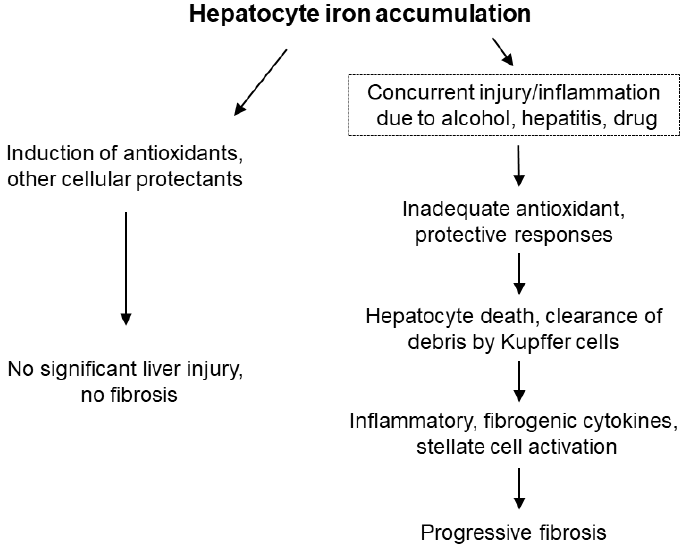
Figure 1. Potential outcomes of hepatocyte iron accumulation. In the setting of iron accumulation alone, iron elicits protective responses and minimal, if any, damage or fibrosis ensues. When iron accumulation occurs in the context of concurrent injury, the induction of protective responses may be impaired, leading to hepatocyte death. Clearance of debris from iron-laden hepatocytes by macrophages generates inflammatory and profibrogenic signals, resulting in progressive fibrosis.